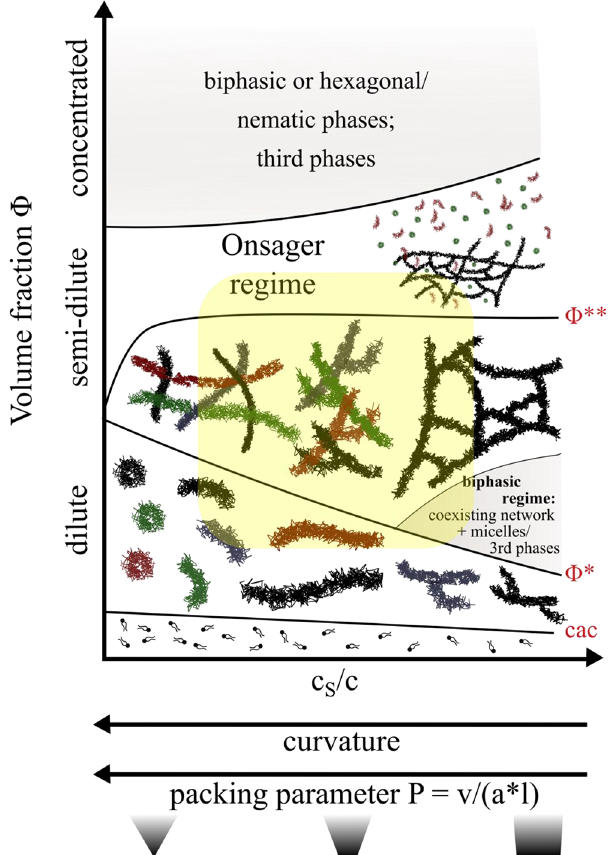
Fig. 12. Schematic view of the different regimes of gelation for concentrated cylinders. Replotted and adjusted from [48]. The microstructure depends both on the volume fraction and the metal concentration determining the spontaneous curvature of the extractant. In yellow, the most probable concentration range is